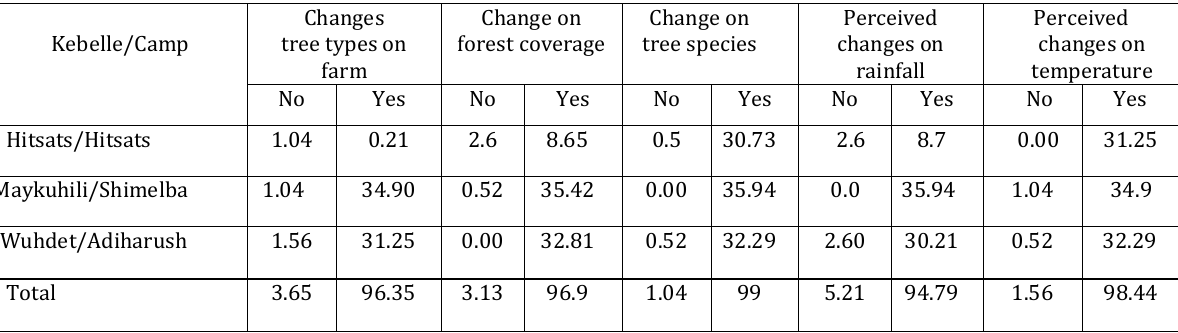
Table 2. Descriptive analysis of the socio-environmental characteristics on the refugee settlement areas (Source: survey computation) Changes Change on Change on Perceived Perceived Kebelle/Camp tree types on forest coverage tree species changes on changes on farm rainfall temperature No Yes No Yes No